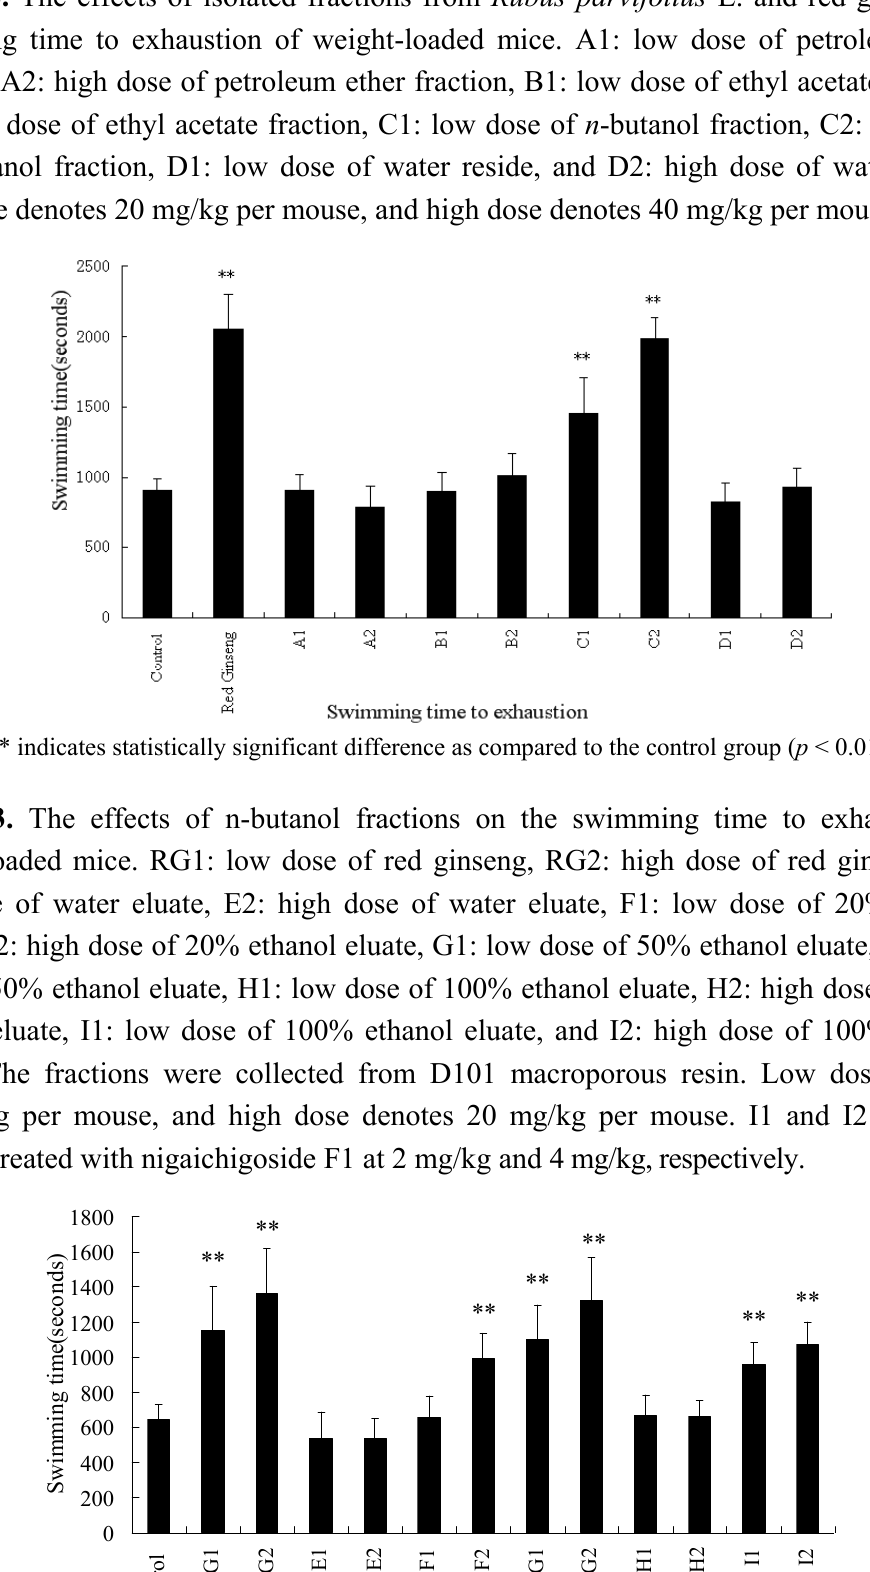
** indicates statistically significant difference as compared to the control group ( p <